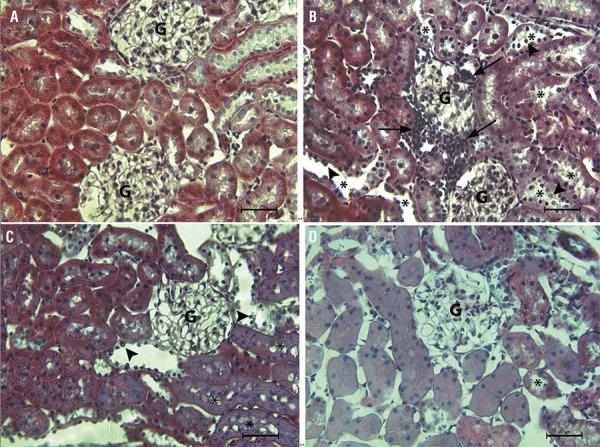
(A-D) - Representative photomicrographs of Masson’s trichrome staining of the renal cortex in the sham group (a) and sepsis group (b) 5mg/kg (c) and 10mg/kg tadalafil+sepsis groups (d). Arrows indicate areas of inflammatory cell infiltration.